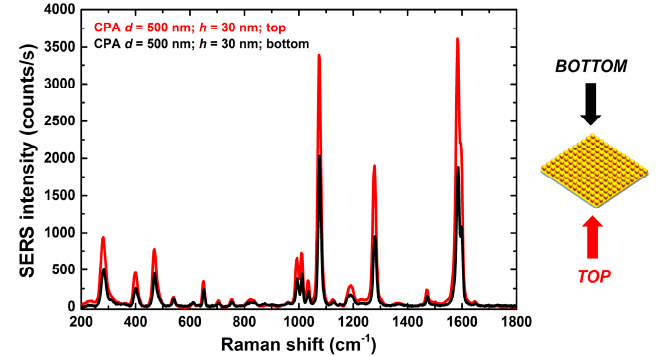
Figure 6. BPT SERS spectra, for the CPA substrate ( d = 500 nm, gold thickness h = 30 nm), acquired in top and bottom configuration (sketch on the right).